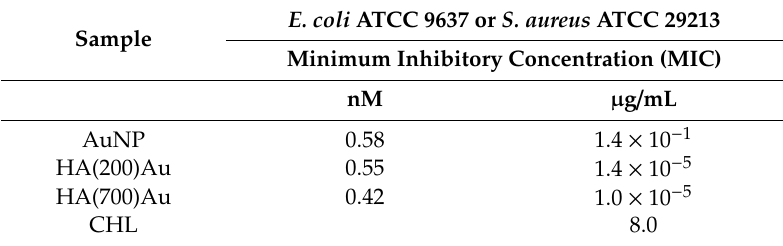
Figure 6. DLS measurements of the hydrodynamic size of nanoparticles before and after the addition of 0.6 M NaCl to: ( a ) bare AuNP, ( b ) HA (200)Au, ( c ) HA(700)Au. (***) = p < 0.001 and (****) = p < 0.0001, vs. the corresponding sample not added with the electrolyte solution (one-way ANOVA). Table 4. Inhibitory activity of bare and HA-capped AuNPs against Escherichia coli ATCC 9637 and Staphylococcus aureus ATCC 29213 in the comparison with the reference chloramphenicol